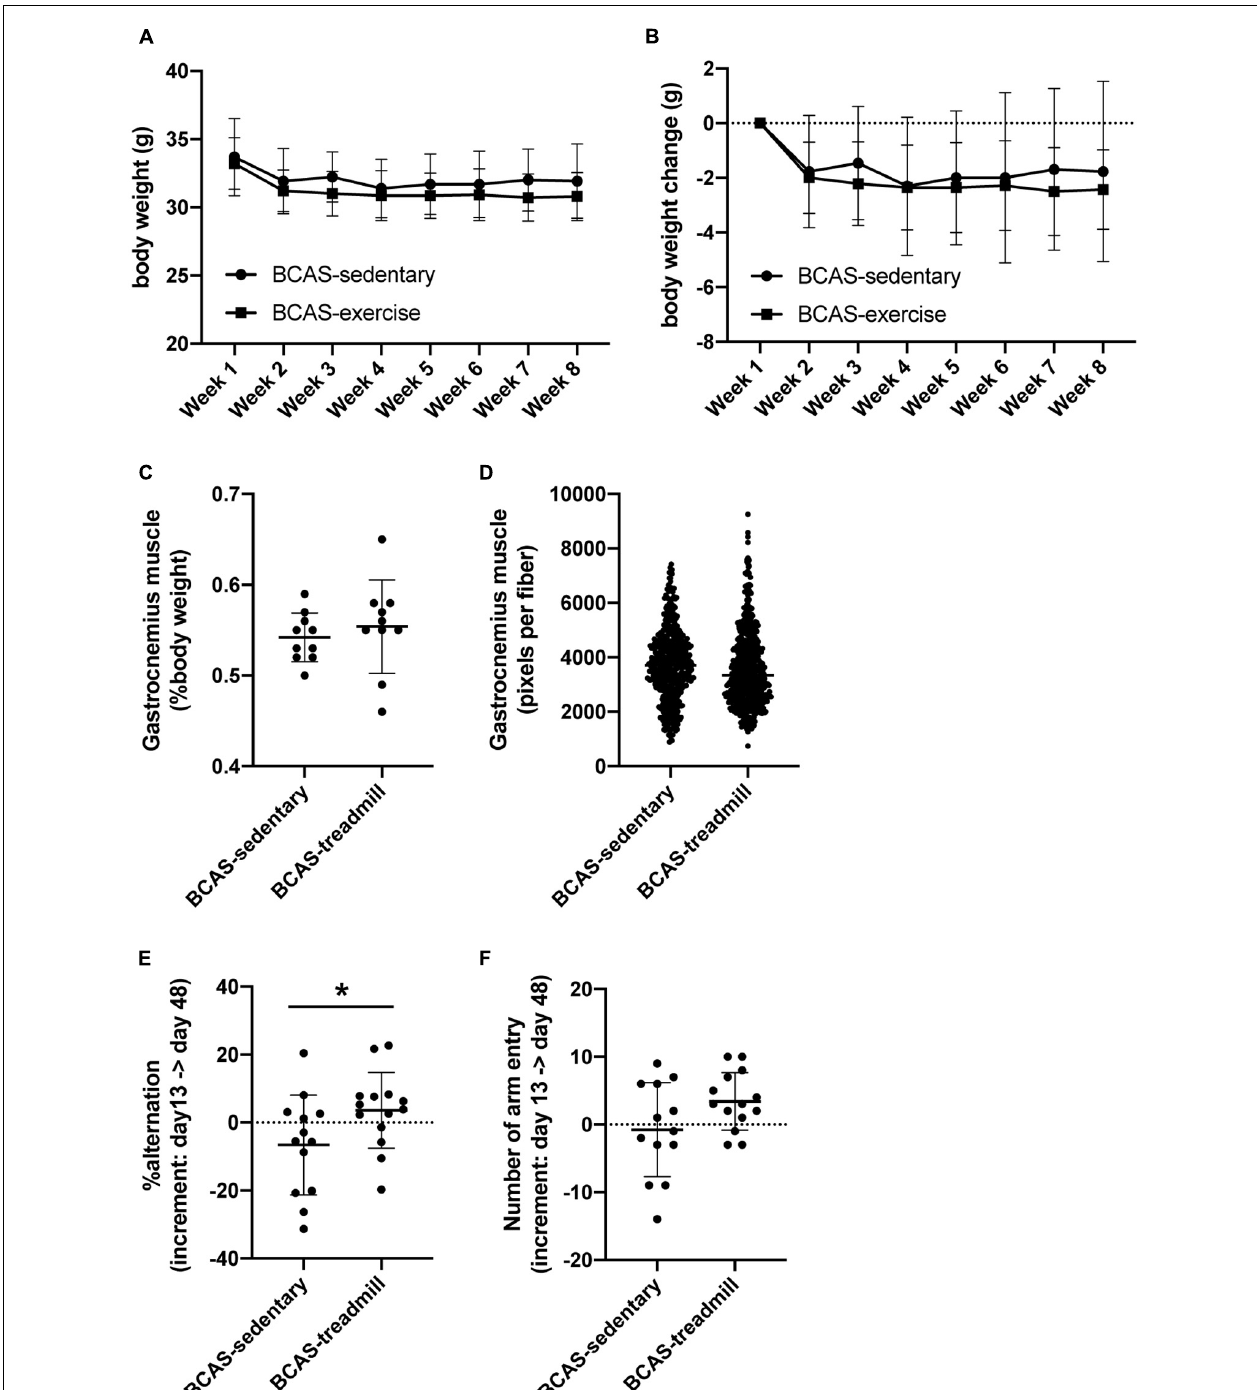
FIGURE 2 | Result of cognitive function test from Experiment 1. (A,B) Body weight transition of mice (A) , and temporal body weight change of mice (B) . There was no significant difference between the 2 groups (BCAS/Sedentary vs. BCAS/Treadmill). Data are expressed as mean ± SD. (C,D) Weight of gastrocnemius muscle (percentage of body weight) (C) and distribution of the area of muscle fibers (D) at day 49. There was no significant difference between the 2 groups (BCAS/Sedentary vs. BCAS/Treadmill). Data are expressed as mean ± SD. (E,F) Change in alternation (an index of working memory) in Y-maze test before and after the training period (E) and change in the number of arm entries in Y-maze test before and after the training period (F) . There was a significant difference in the increment of alteration between the 2 groups (BCAS/Sedentary vs. BCAS/Treadmill) (* P < 0.05, Mann-Whitney U test). Data are mean ± SD.